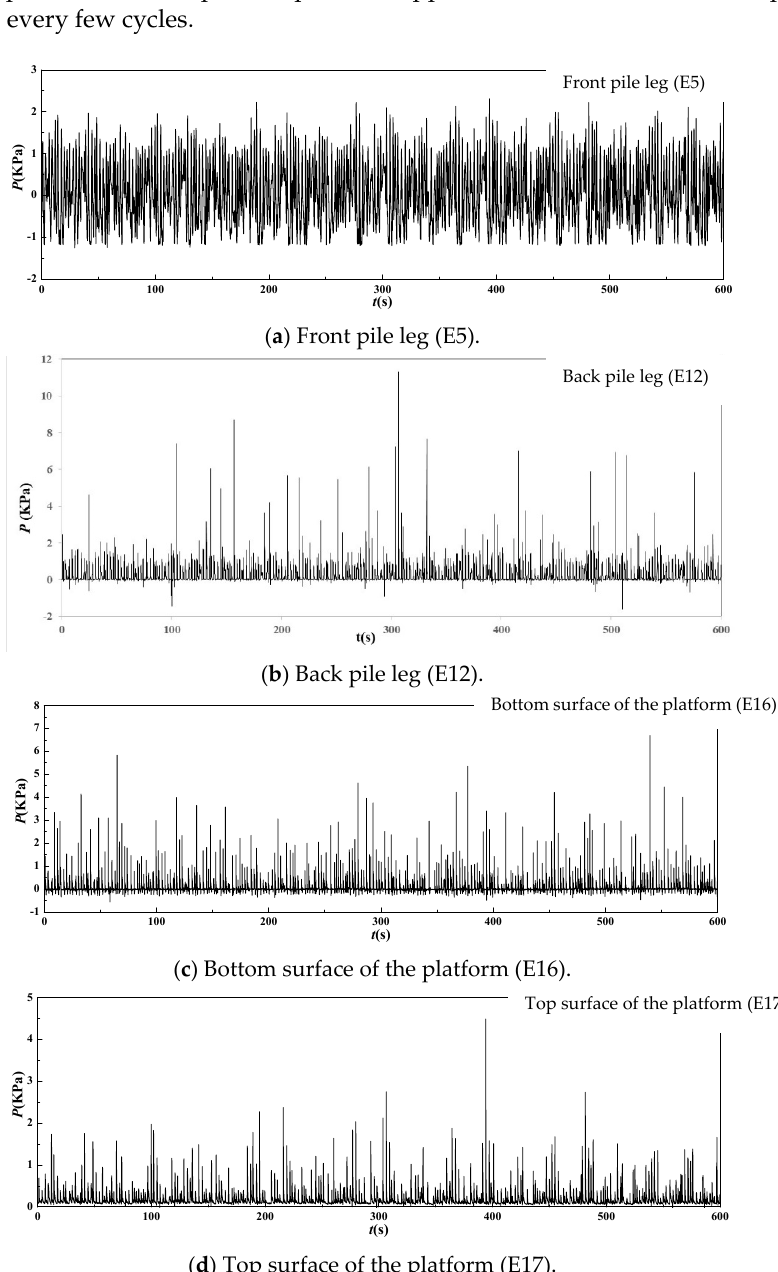
Figure 9. Wave pressure history of the platform model under waves (H w = 62.5 cm, H s = 30.0 cm, T = 2.45 s).